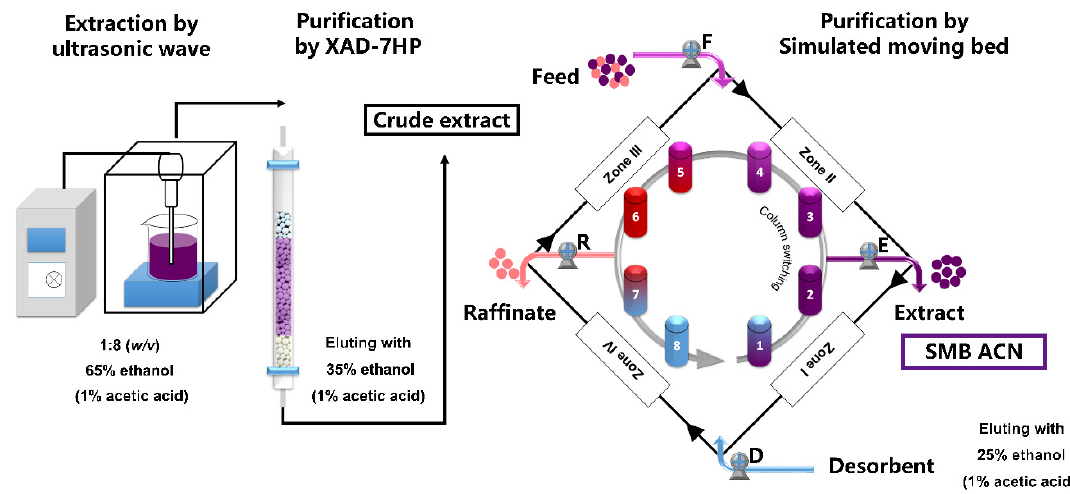
Figure 1. Schematic illustration of the isolation and purification of anthocyanins from black chokeberry fruits. The antho- cyanins were isolated by an ultrasonic extraction method and the crude extract was prepared by XAD-7HP macroporous resins as the feed of simulated moving bed chromatography (SMB). The separation zones of SMB were zones II and III, and the solid phase was regenerated in zones I and IV with two columns per zone. The liquid phase (black) consisted of feed and desorbent for inlets, and extract and raffinate for outlets by pump E and pump R. The liquid phase was continuously fed the crude extract by pump F and eluted with ethanol by pump D. Then, SMB ACN was collected from the extract. The columns switched counter-clockwise (gray) at the switching time intervals.